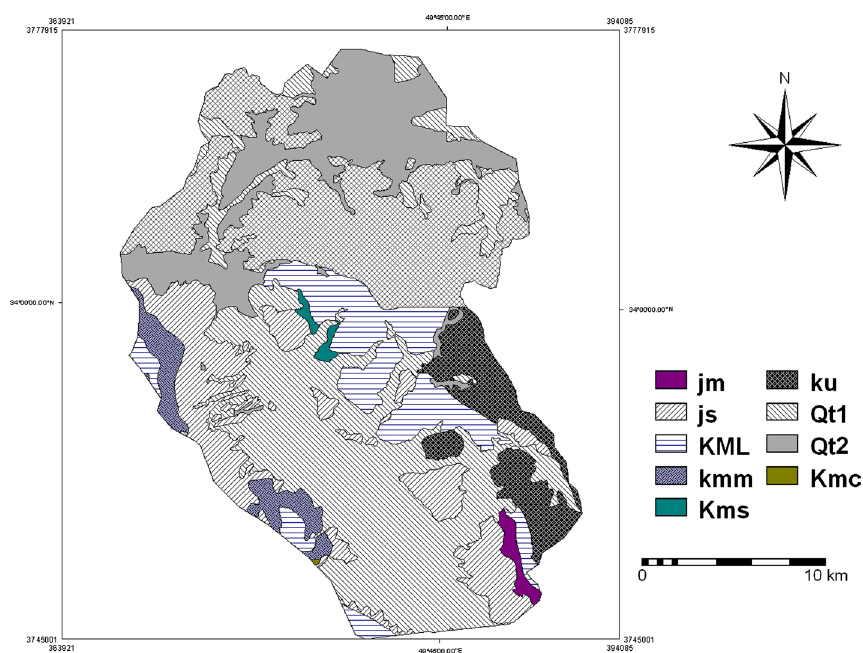
Fig. 3 The geology map of